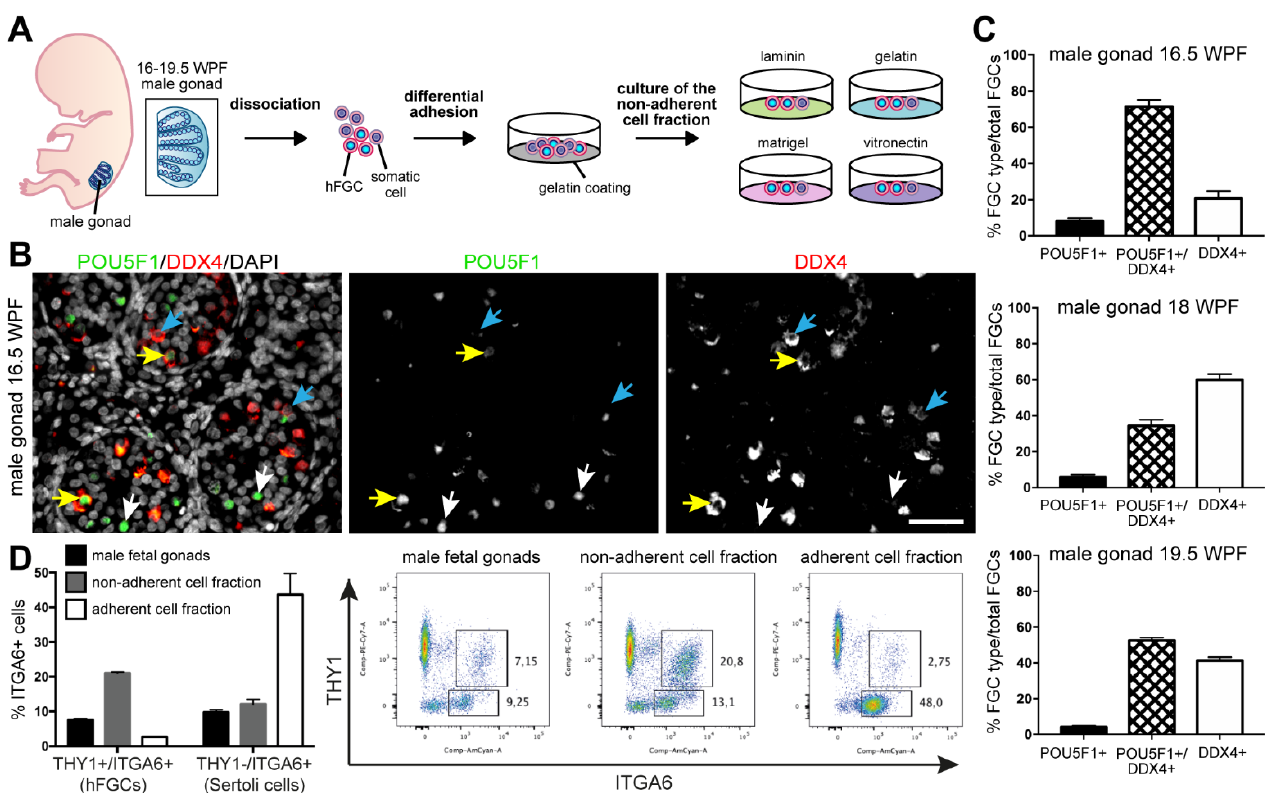
Figure 1. Characterization of POU5F1 and DDX4 expression in hFGCs in human fetal testes. ( A ) Experimental design used in this study. ( B ) Immunofluorescence for (nuclear) POU5F1 and (cytoplasmic) DDX4 in male gonads of 16.5 WPF. White arrows show POU5F1+ hFGCs, yellow arrows show double POU5F1+/DDX4+ hFGCs and blue arrows show DDX4+ hFGCs. Scale bar is 50 μ m. ( C ) Percentage of POU5F1+, double POU5F1+/DDX4+ and DDX4+ hFGCs in male gonads of 16.5, 18 and 19.5 WPF ( n = 3 different donors) (mean ± SEM). ( D ) hFGC enrichment analysis. Quantification of the percentage of THY1+/ITGA6+ and THY1-/ITGA6+ cells in the male fetal gonads of 19 WFP in the adherent and in the non-adherent fraction (mean ± SEM) and representative FACS dot-plots.